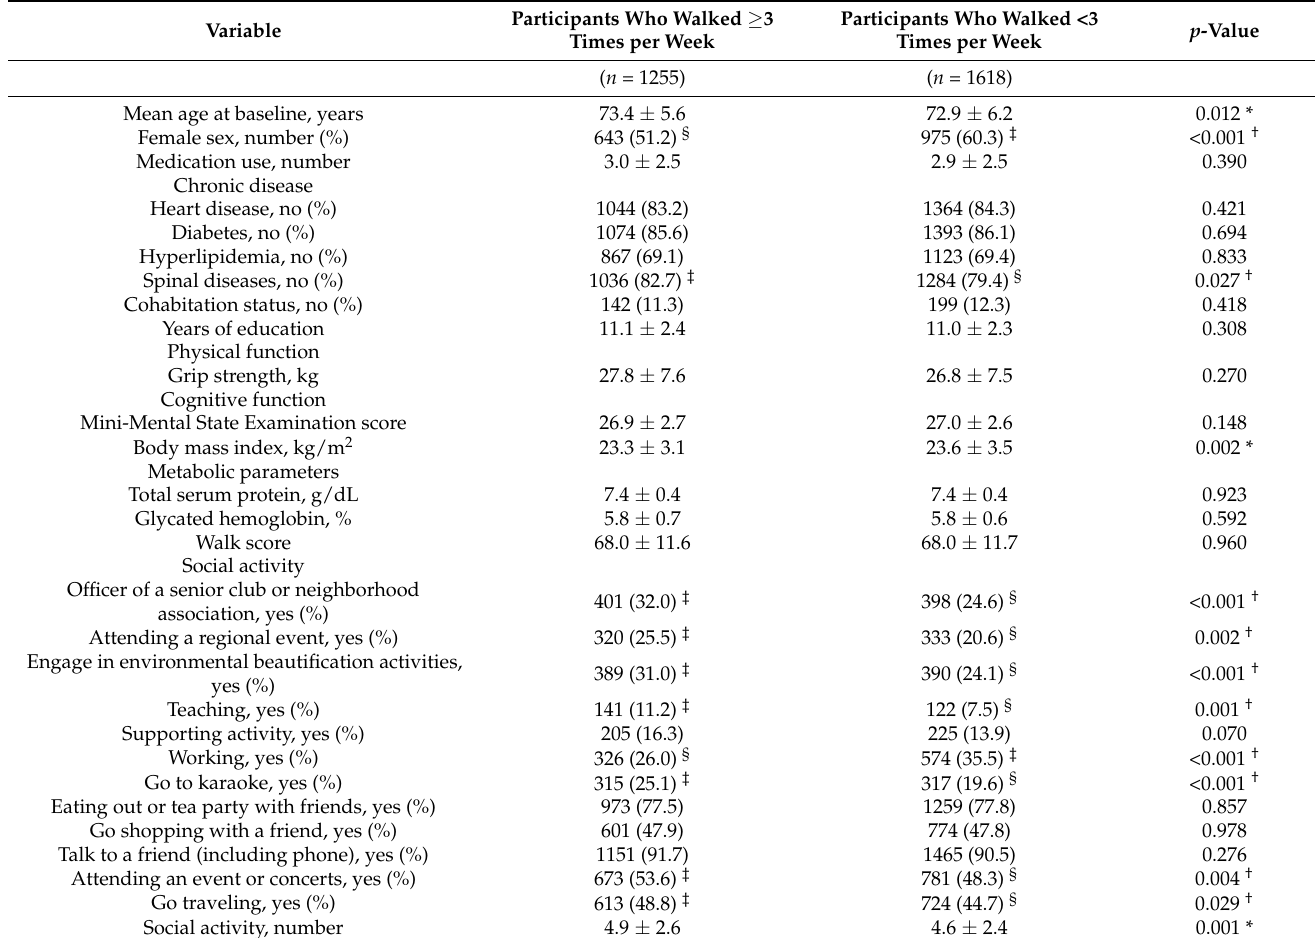
Table 2. Baseline characteristics of the study participants by walking